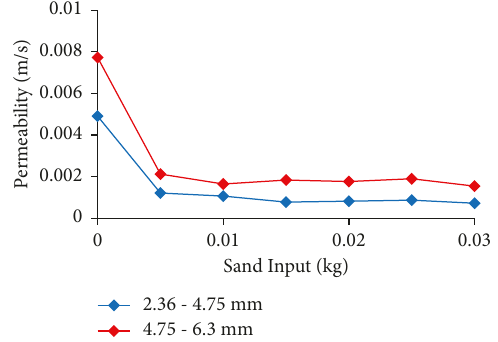
Figure 10: Comparison of permeability due to sand clogging.